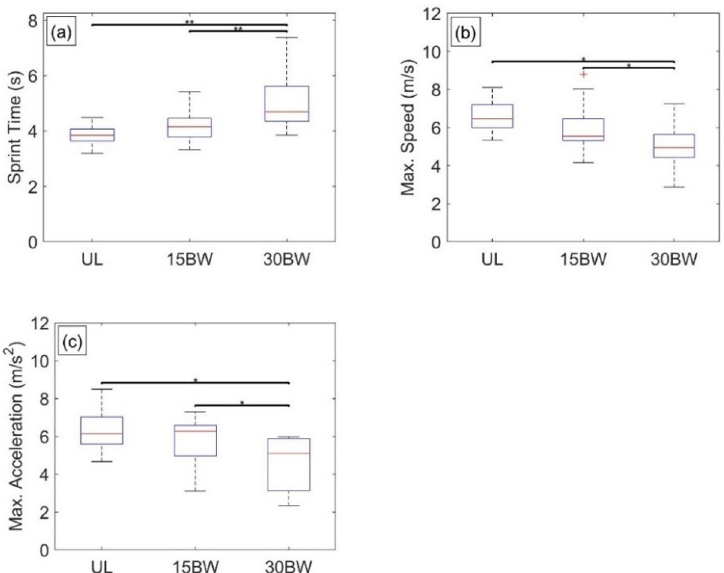
Fig 3. Sprint statistical results. Boxplots depicting the results from the Tukey post hoc analysis for a) sprint time, b) maximum speed, and c) maximum acceleration. The bars denote significant differences between loading conditions at a significance level α = 0.05 � , 0.01 �� , 0.001 ���